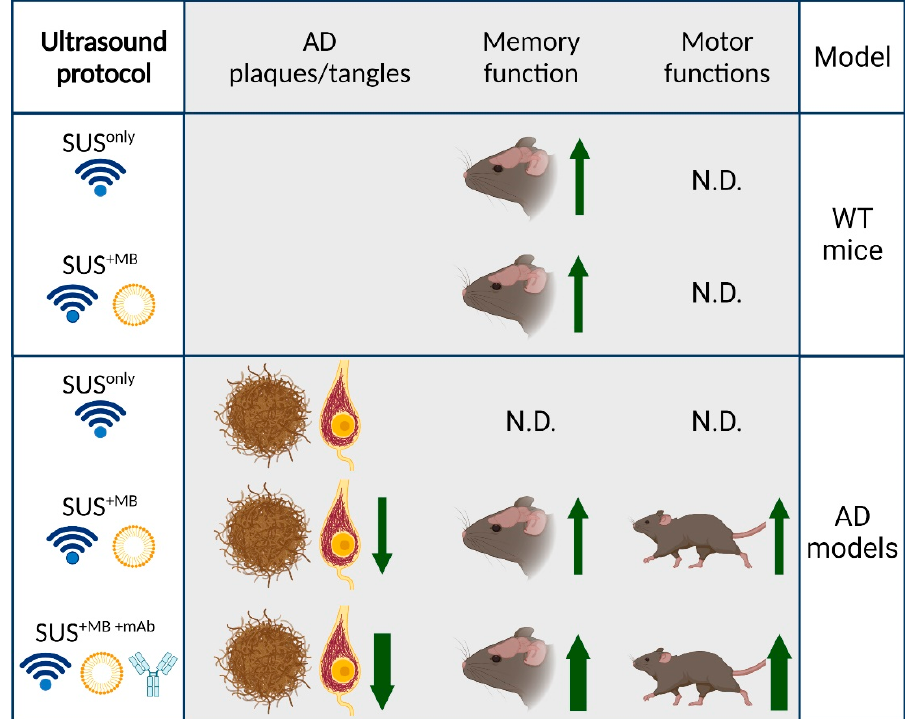
Figure 1. Three fundamental modes of ultrasound application (SUS only , SUS +MB , and SUS +MB+mAb ) to wild-type mice and Alzheimer’s disease (AD) mouse models, showing the impact on AD pathology (plaques and tangles), memory, and motor functions. N.D.—not determined. Created with BioRender.com.